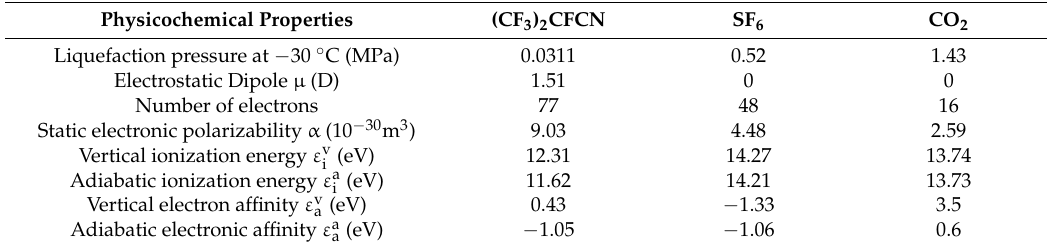
Table 13. Physicochemical properties of some gases